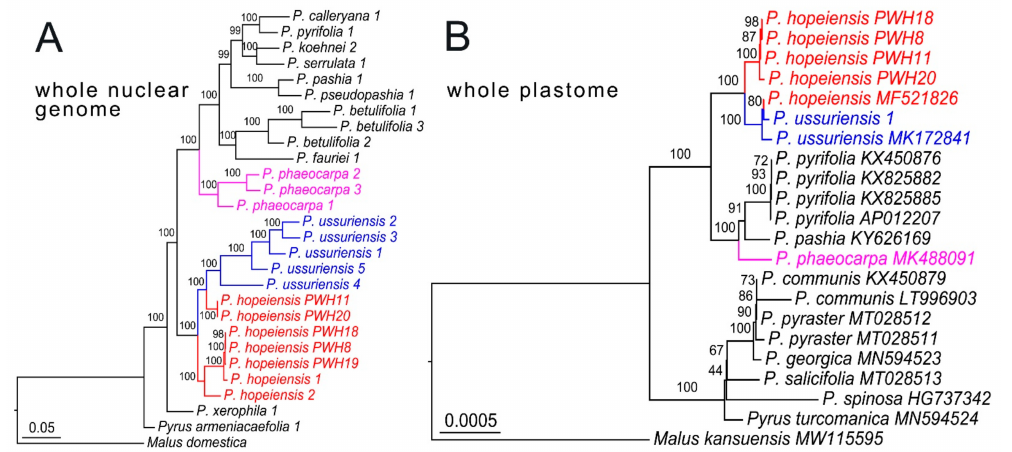
Figure 2. Maximum likelihood phylogenetic tree inferred from the SNP data matrix based on the whole-genome resequencing data ( A ) and whole plastid genome sequences ( B ). The numbers